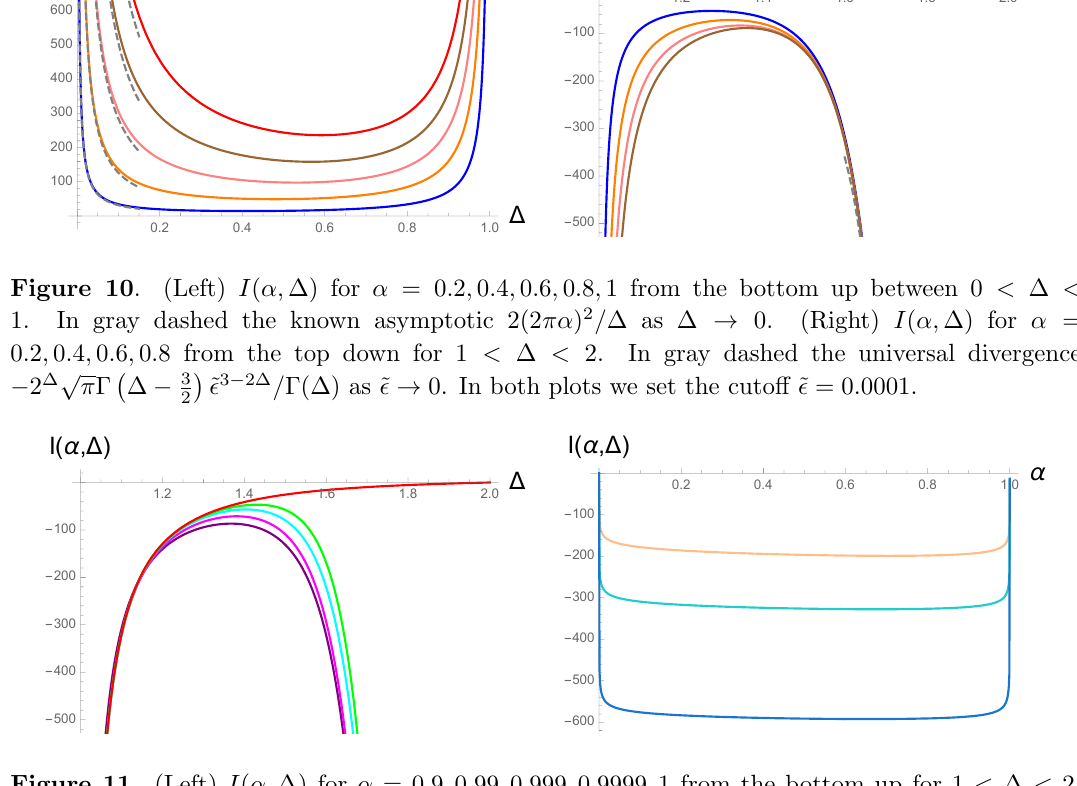
Figure 11 . (Left) I ( (cid:11); (cid:1)) for (cid:11) = 0 : 9 ; 0 : 99 ; 0 : 999 ; 0 : 9999 ; 1 from the bottom up for 1 < (cid:1) < 2. (Right) I ( (cid:11); (cid:1)) for (cid:1) = 1 : 55 ; 1 : 6 ; 1 : 65 from the top down. In both (cid:12)gures ~ (cid:15) = 0 :